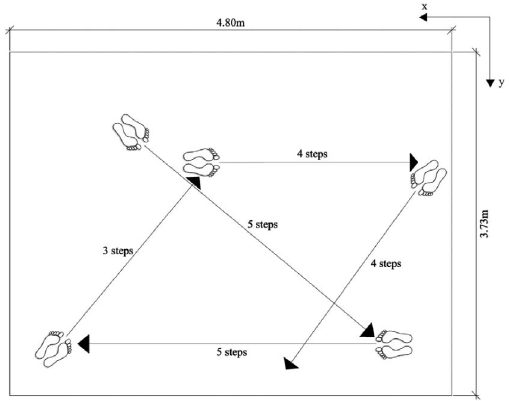
Figure 4. Walking path of the virtual walker.